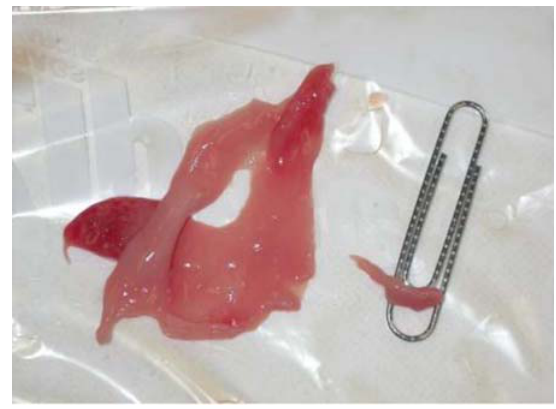
Figure 3. The tissue from Case 2, partial